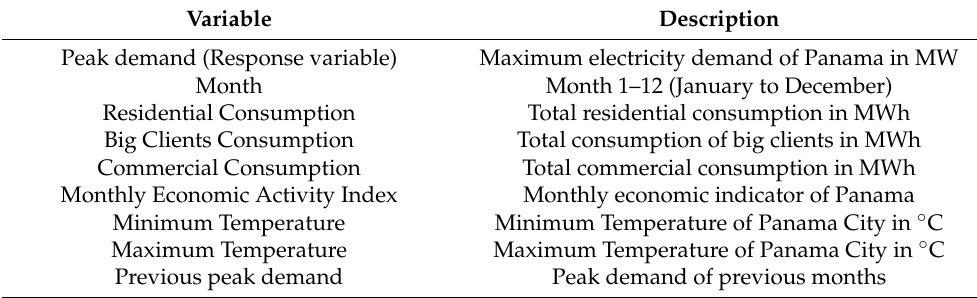
Figure 7. Boxplot of the peak demand by month. Table 2. Variables considered for predicting the peak